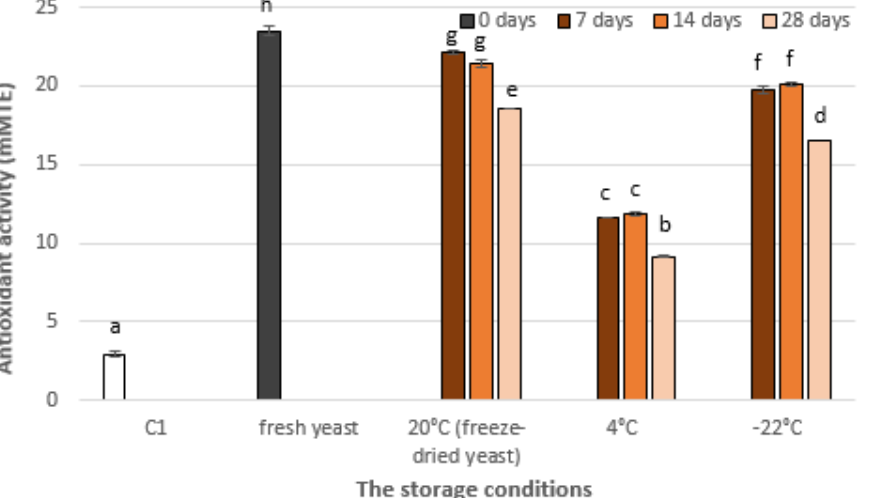
Figure 7. Effect of storage (0-fresh yeast, 7, 14, 28 days) on the antioxidant activity of an extract from yeast treated with PEF (vitamin C, 5 mg/mL medium; voltage, 1000 V; pulse width, 10 µs; treatment time, 20 min; number of pulses, 1200; after 20 h of cultivation) determined by the DPPH radical method. Sample C1 was yeast without vitamin C and PEF treatment. Each value is the mean ± standard deviation ( n = 3). Bars with the same letter (a–h) are not significantly different ( p < 0.05).